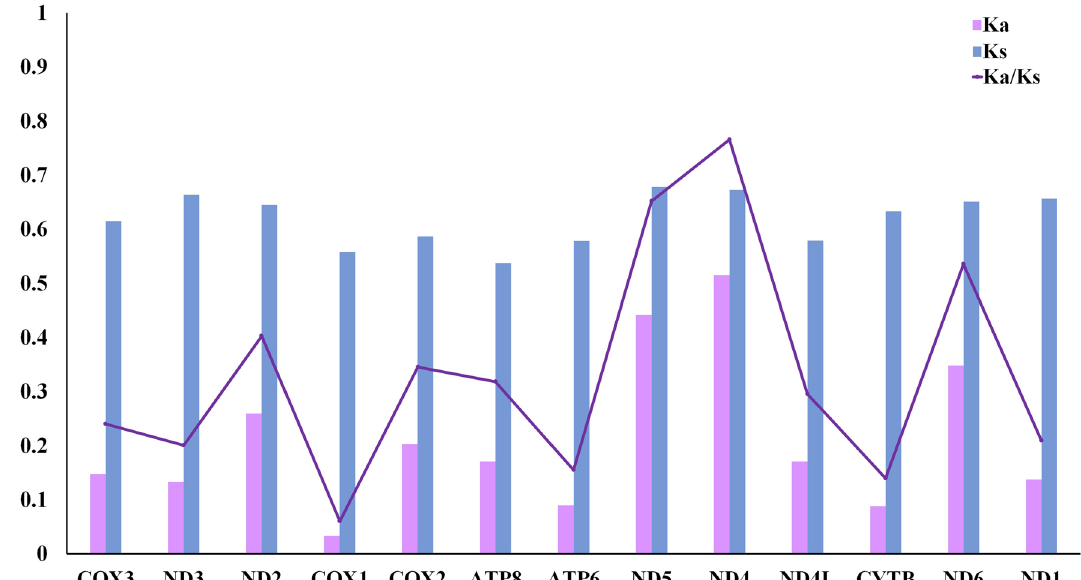
Figure 4. The purple line indicates the mean pairwise divergence of the Ka/Ks ratio for 13 PCGs among 16 Neritimorpha mitochondrial genomes. The 16 species of Neritimorpha are listed in Table 1. The pink and blue boxes indicate the number of nonsynonymous substitutions per nonsynonymous site (Ka) and the number of synonymous substitutions per synonymous site (Ks), respectively.